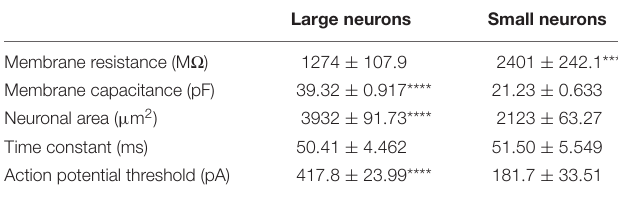
TABLE 2 | Membrane properties of recorded OB DA neurons based on neuronal area. Large neurons Small